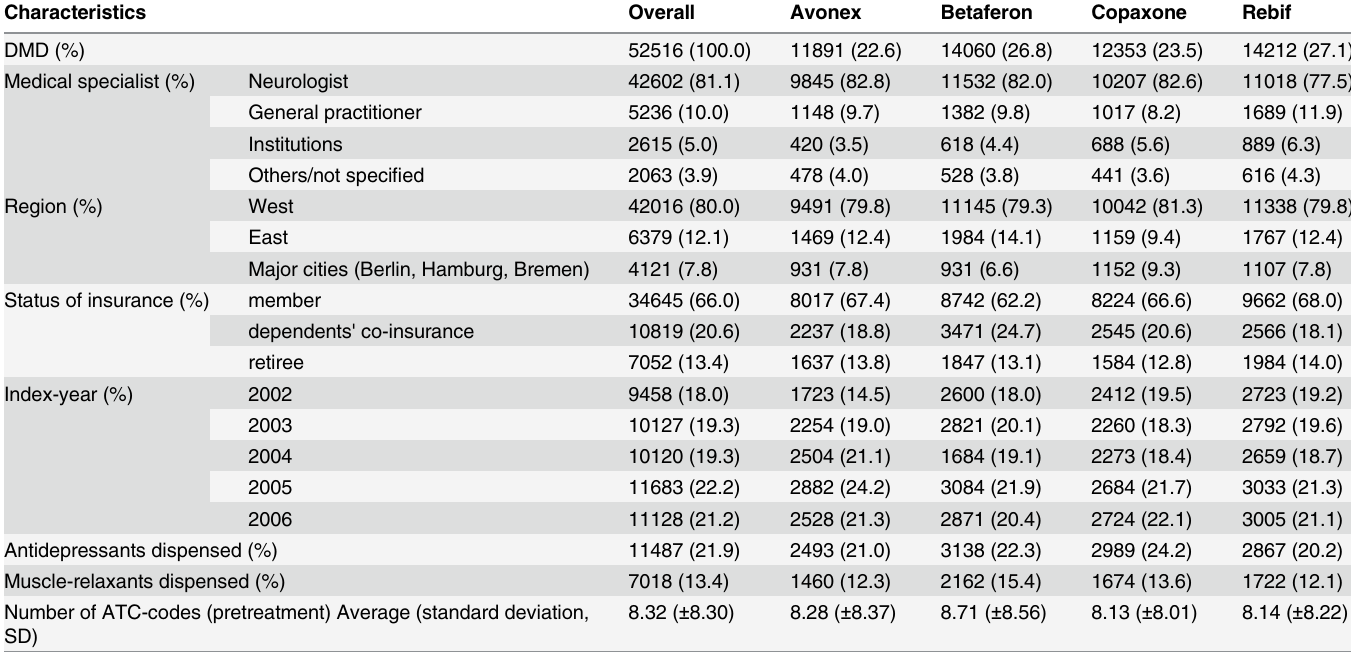
Table 1. Cohort characteristics of the main study cohort at the index